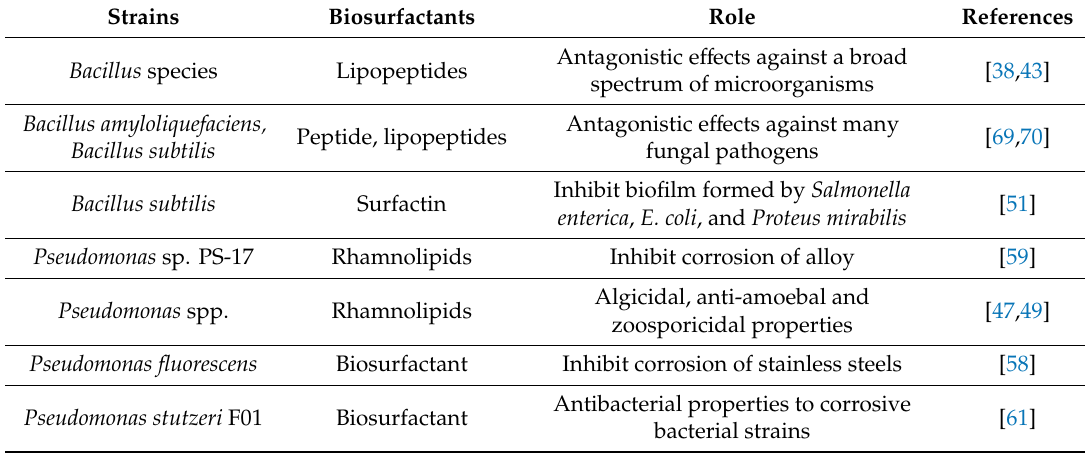
Table 1. Biosurfactants derived from Bacillus and Pseudomonas strains and their role in biocorrosion